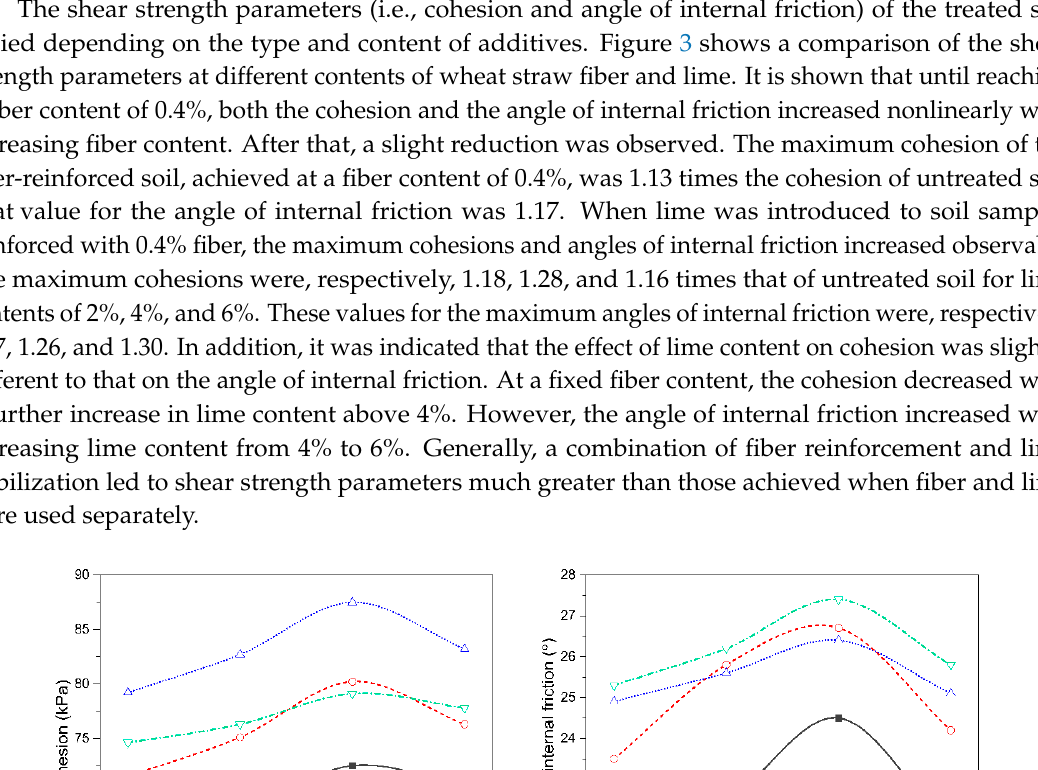
Figure 4. Secant moduli at four strain levels tested at σ 3 = 200 kPa: ( a ) samples reinforced with fibers or stabilized with lime and ( b ) fiber-reinforced samples stabilized with lime. The secant moduli at a 1.2% axial strain level for untreated soil, fiber-reinforced soil, lime-stabilized soil, and fiber-reinforced soil stabilized with lime are shown in parallel in Figure 5, where the percentages represent the rates of increase in the secant moduli compared to that of untreated soil. Note that each of the percentages presented below the bars was calculated by adding the rate of increase in the secant modulus produced by fiber reinforcement to that produced by lime